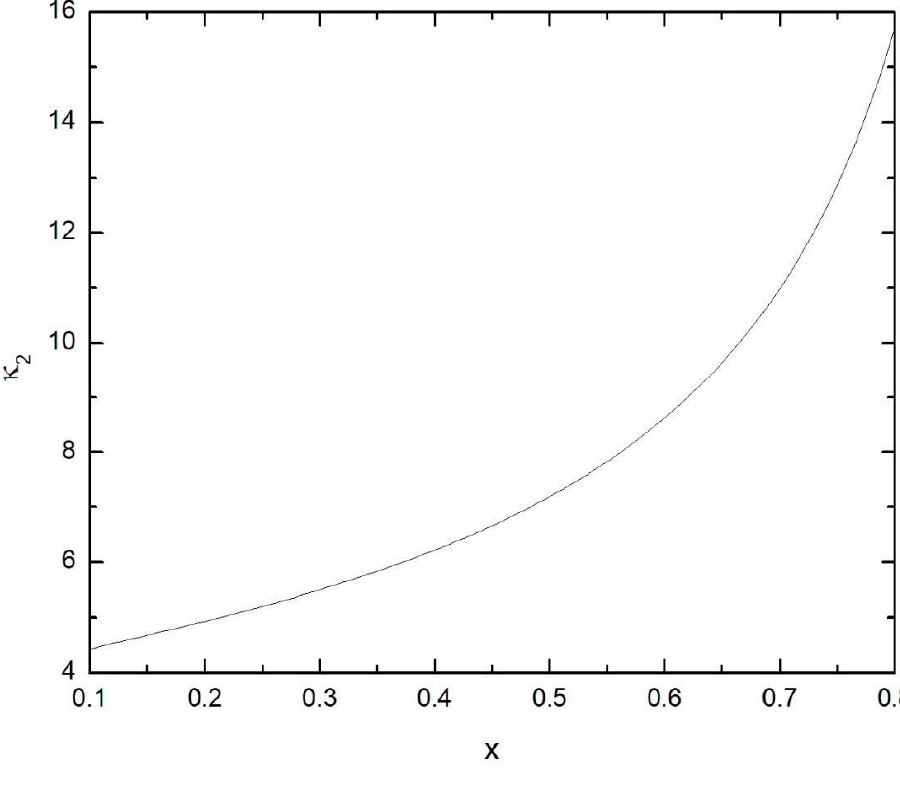
Figure A2. The dependence of the enhancement factor on the value of the ratio of reflectance at two channels.